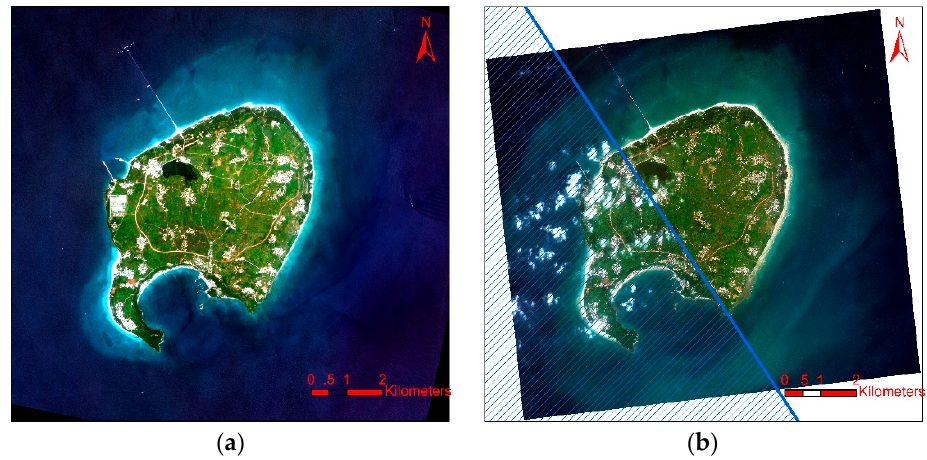
Figure 5. The experimental multispectral images: ( a ) the ZY-3 multispectral image; and ( b ) the WV-3 multispectral image. Based on the division represented by the straight line, the western region of the WV-3 image may be seriously influenced by clouds; therefore, we only study the eastern region of the WV-3 image in our experiments.